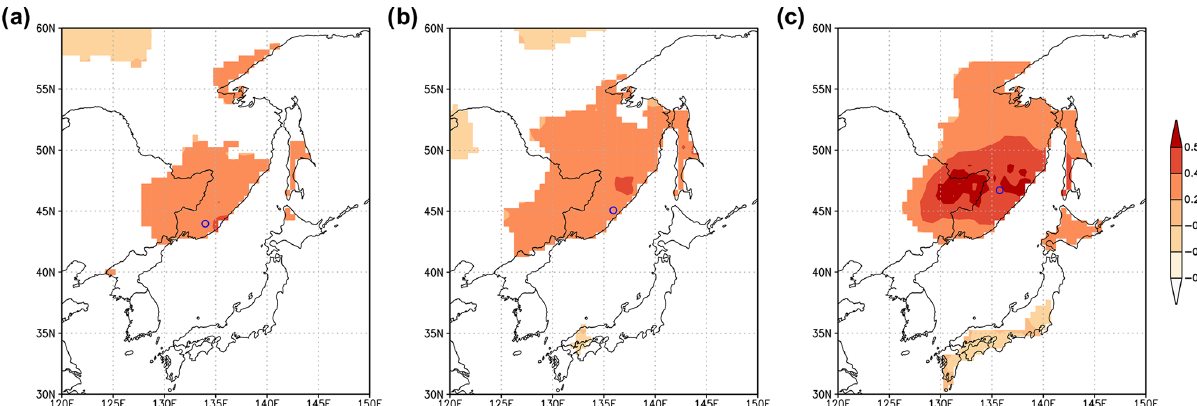
Figure 8. Spatial correlation pattern of gridded precipitation CRU TS 4.03 with the reconstructed precipitation using the Climate Explorer website (http://climexp.knmi.nl, last access: 26 April 2021): (a) April–June (SSA), (b) March–June (CSA) and (c) March–July (NSA). The sample sites are marked with circles. Analysis periods are 1936–2004, 1941–2009 and 1940–2013 for SSA, CSA and NSA, respectively; p < 0 .